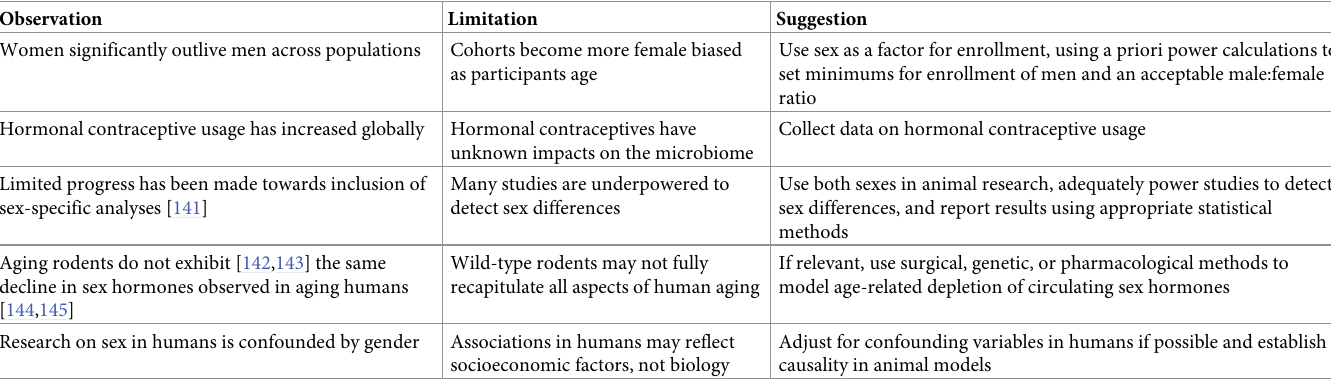
Table 1. Accounting for biological sex in microbiome and aging